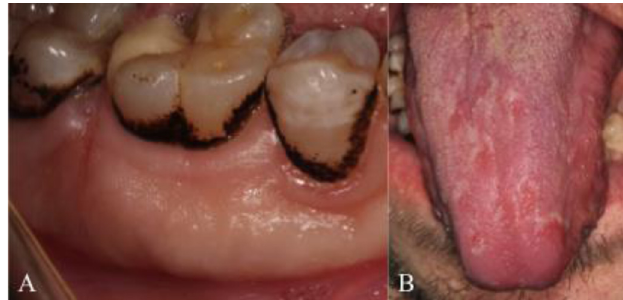
Fig. 4. Oral mucous examination. Figure presents mucous membrane abnormalities, (A) on the gingiva and (B) on the tongue. (A) shows gingival hyperkeratosic lesions. (B) shows benign migratory glossitis.